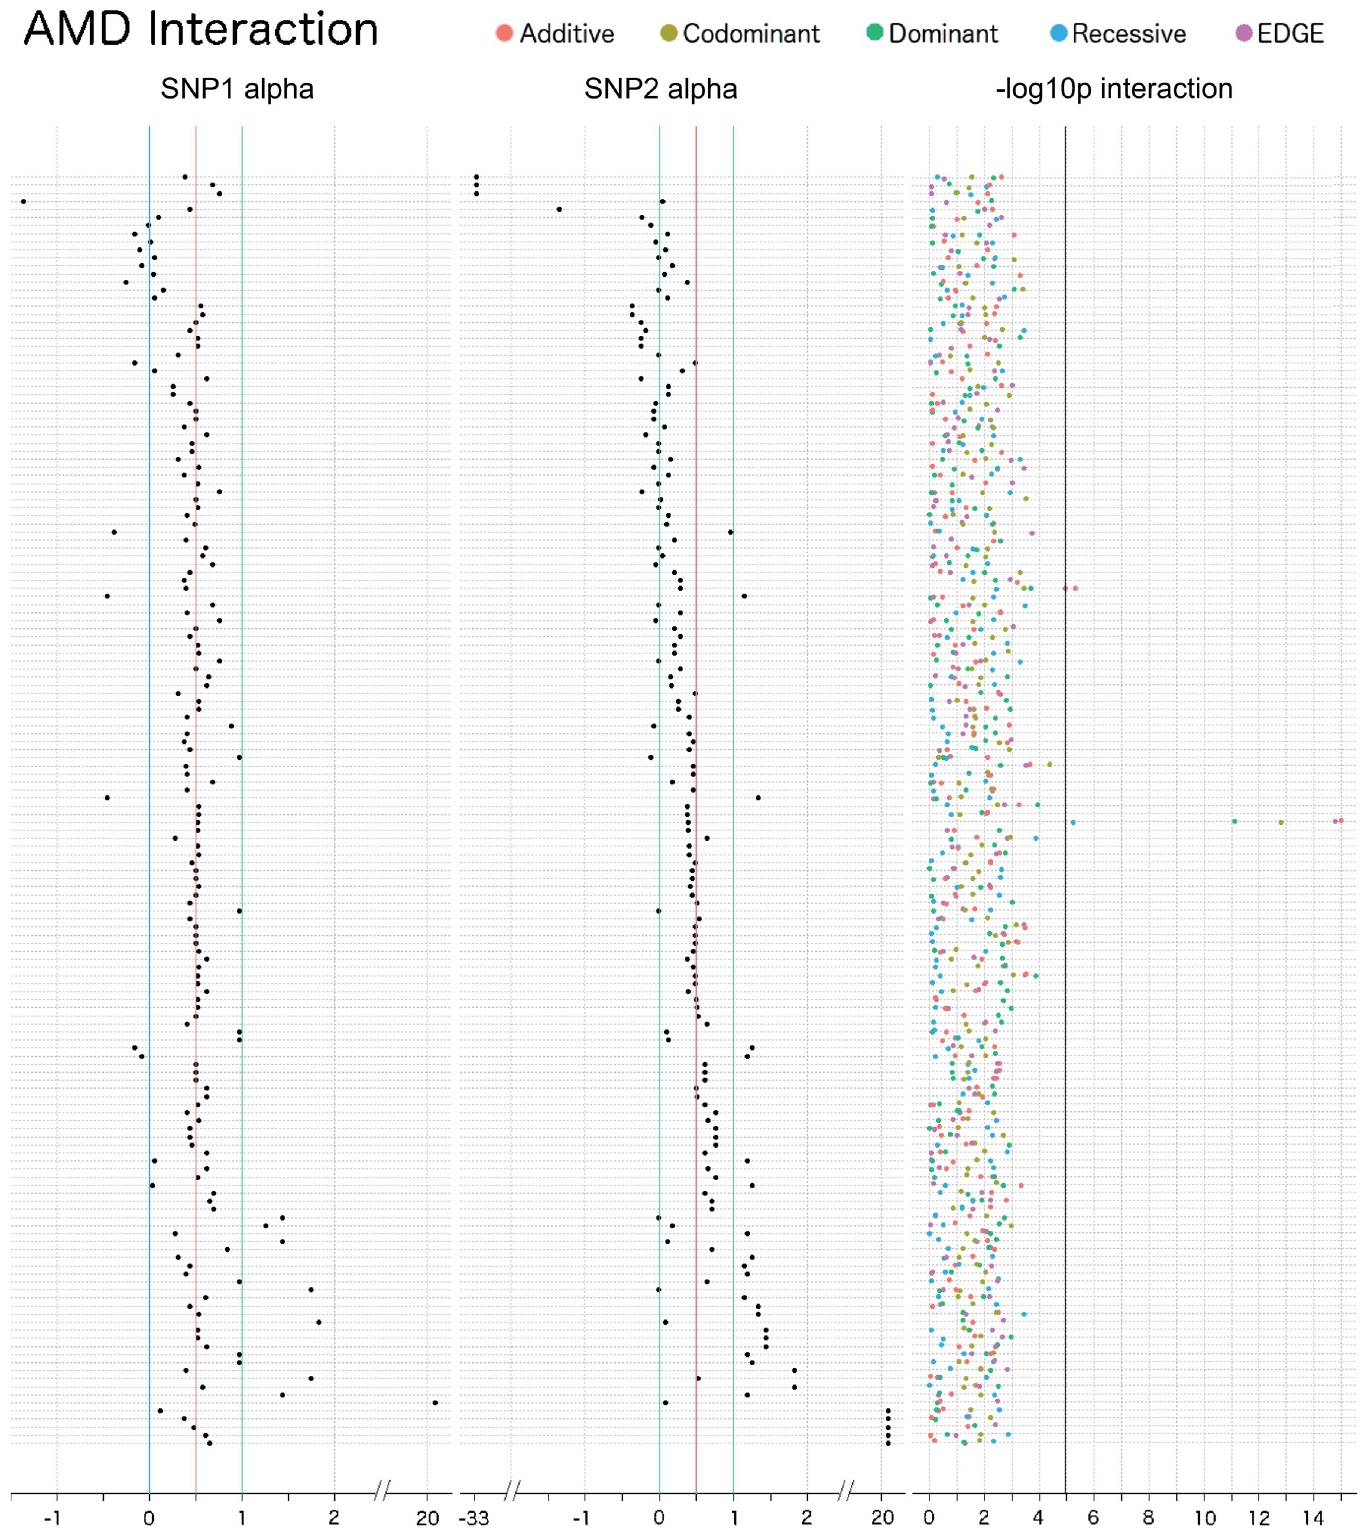
Fig 13. Interaction plot of the top results from the main effect filtered SNP-SNP interaction analysis for AMD. The top 50 SNPs from the multi-encoding AMD GWAS were considered for a pairwise SNP-SNP interaction analysis using additive (red), dominant (green), recessive (blue), codominant (yellow) and EDGE (purple)